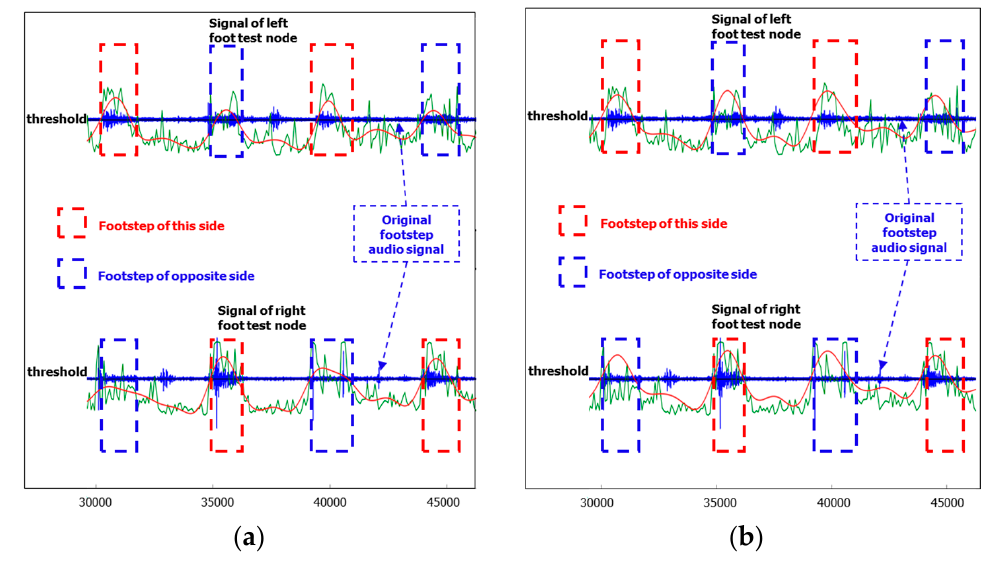
Figure 5. ( a ) Low-Pass-Filter smoothing result (red) for the probability curve (green); ( b ) Footstep detection by two-footstep-audio signal fusion.